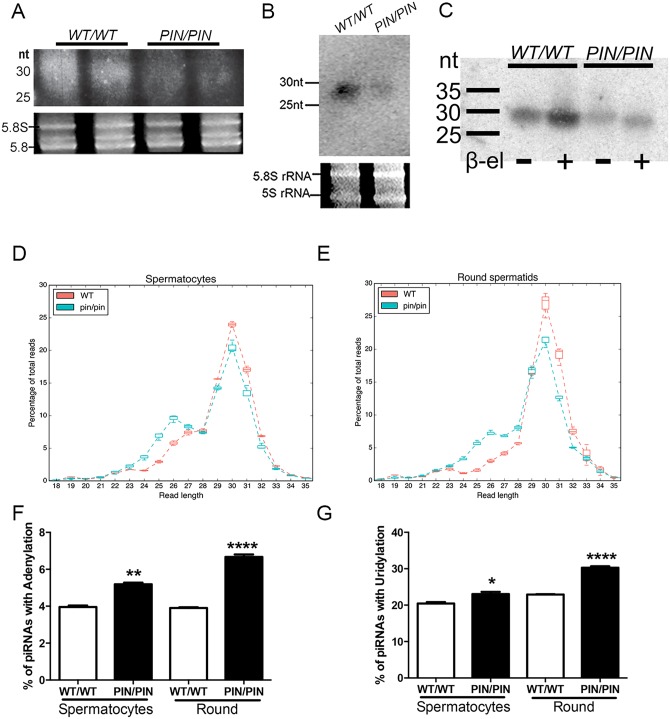
HENMT1 loss results in decreased piRNA bulk and the absence of 3’ 2’-O-methylation and stability.
(A-B) A representative image illustrating a ~51% reduction in the abundance of piRNAs in Henmt1
PIN/PIN and Henmt1
WT/WT 30 day-old testes as indicated on an acrylamide gel (total piRNAs, A) and a small RNA northern blotting for pachytene piRNA1 (B). 5.8S and 5S rRNAs were used as loading controls. Statistics were carried out on n-4 biological replicates per genotype. (C) The effects of β-elimination on piRNA length. 5.8S and 5S rRNAs were used as loading controls. (D-E) piRNA length distributions, expressed as a percentage of total, in Henmt1
WT/WT and Henmt1
PIN/PIN. (F-G) The percentage of piRNAs with (F) adenylation (last base of read was A when the reference base was not A) and (G) uridylation (last base of read was T, reference base was not T) at their 3’ end in spermatocytes and round spermatids (n = 2 / Henmt1
WT/WT spermatocytes, n = 3 Henmt1
WT/WT round, Henmt1
PIN/PIN spermatocytes and round +/- SD, * p<0.05; ** p<0.01; ***p<0.001; ****p<0.0001). Round = round spermatids. A two-tailed unpaired student T-test was performed for statistical analysis.